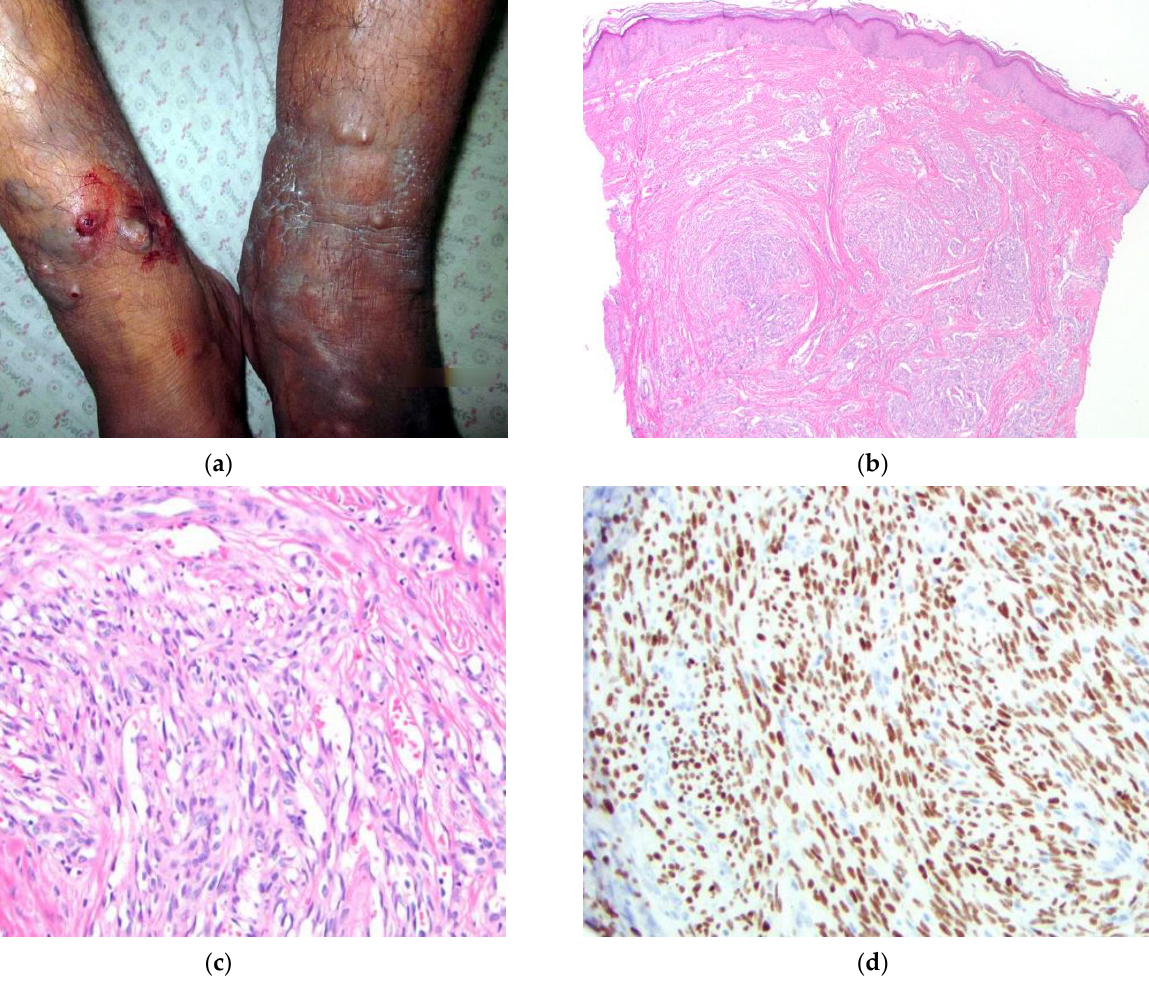
Figure 2. ( a – d ) Patient #2. Image ( a ) Multiple, violaceous patches, nodules, and papules of bilateral lower extremities (left > right) with mild lymphedema of left leg. Image ( b ) H&E 40 × . Multiple nodules within the deep dermis. Image ( c ) H&E 200 × . Spindled cell proliferation forming slit-like spaces. No significant RBC extravasation is identified. Image ( d ) IHC HHV-8 200 × . Strong and diffuse nuclear staining of spindled cells within the